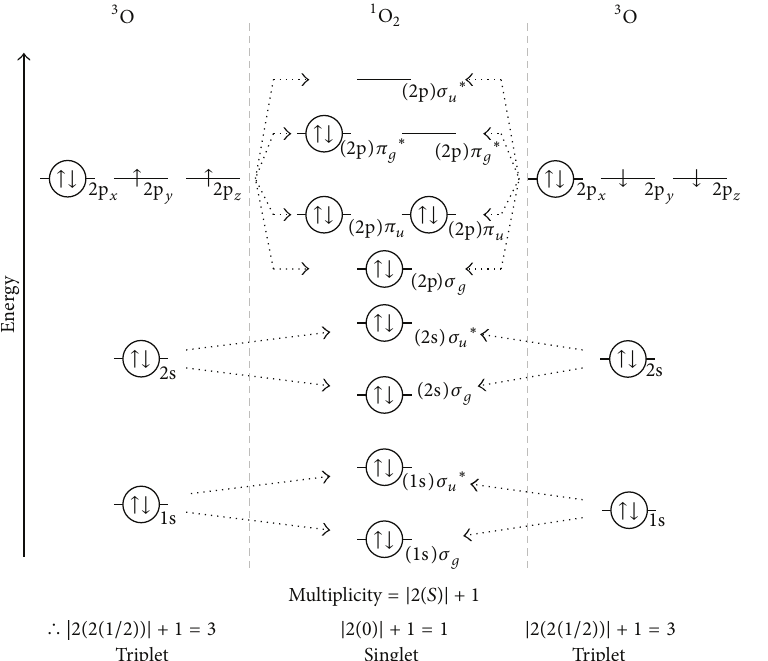
Figure 4: Combination of two triplet multiplicity oxygen atoms ( 3 O) to yield electronically excited singlet multiplicity molecular hydrogen ( 1 O 2∗ ).